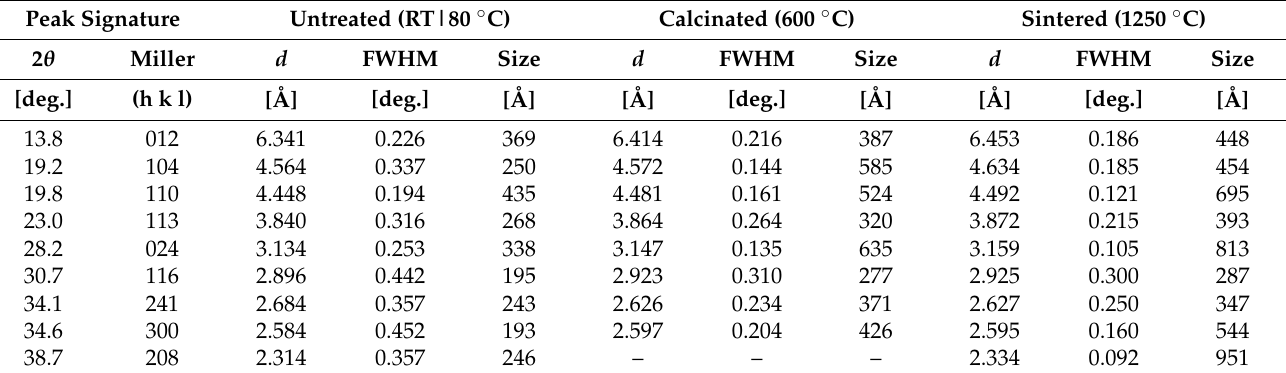
Table 2. XRD parameters of primary NASICON peak signatures for the untreated, calcinated, and sintered powdered materials.